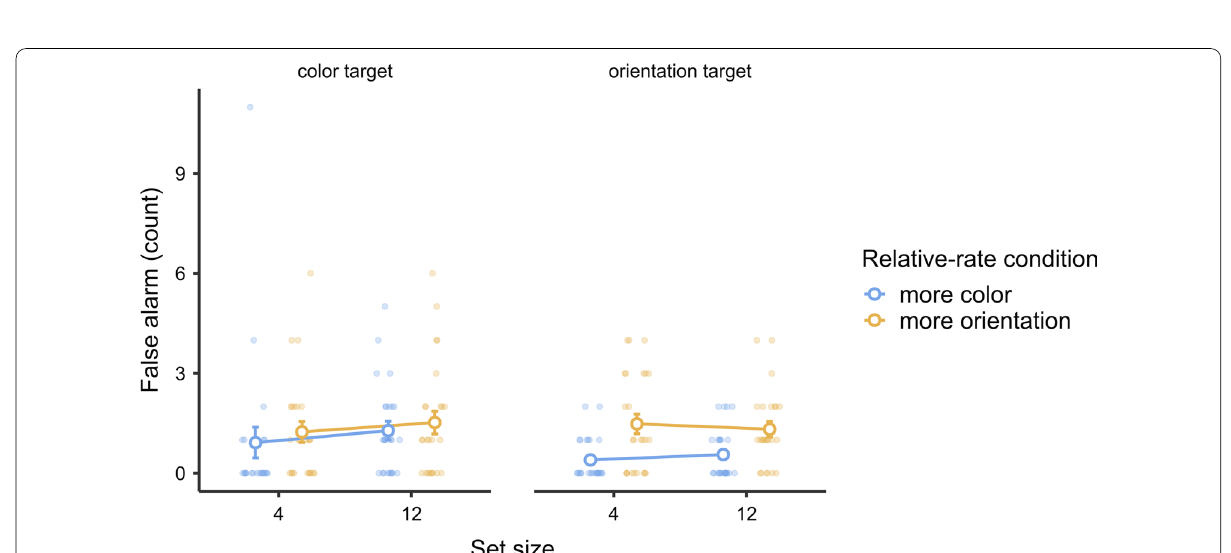
Fig. 8 Experiment 3 results: false alarms. Note In Experiment 3, there were no relative target-rate effects in terms of false alarms. Error bars represent 1 standard error of the ±